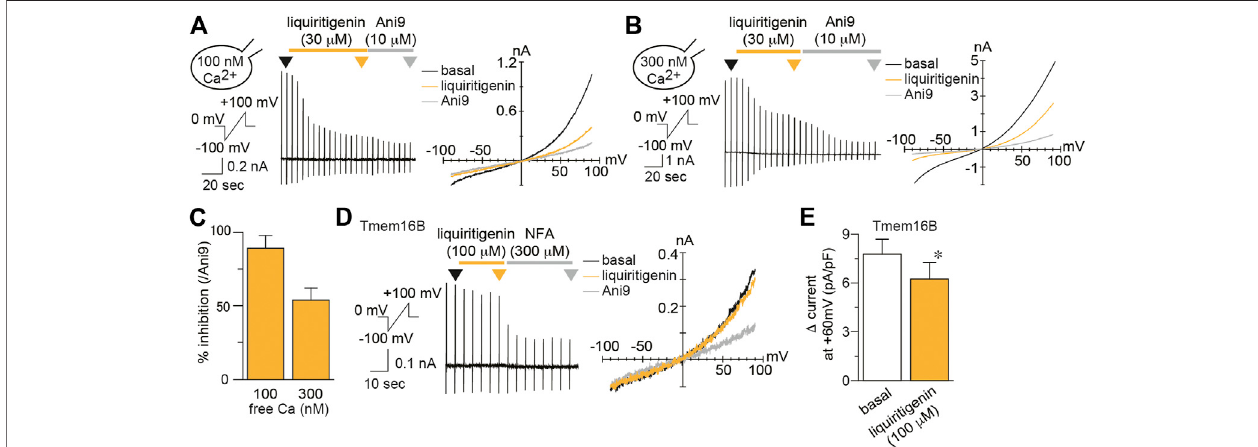
FIGURE 2 | Characterization of liquiritigenin (A – B) Typical traces (left) and current-voltage curves (right) of mTMEM16A currents induced by 100 nM (A) or 300 nM (B) intracellular free calcium during application of 30 µM liquiritigenin to HEK293T cells expressing mTMEM16A. The holding potential was 0 mV, and ramp pulses ( − 100 to +100 mV, 300 ms) were applied every 5 s. Typical current-voltage curves at the time indicated by black (basal), yellow (liquiritigenin), and gray (Ani9) arrowheads (C) Thepercentage ofinhibition causedby30 µMliquiritigeninappliedwith100and300 nMintracellular freecalciumconcentrations(n (cid:2) 5 – 6cells) (D) A typical trace (left) and current-voltage curves (right) of whole-cell chloride currents during application of 100 µM liquiritigenin in HEK293T cells expressing mTMEM16B. The holding potential was 0 mV, and ramp pulses ( − 100 to +100 mV, 300 ms) were applied every 5 s. Basal mTMEM16B currents were induced by 300 nM intracellularfreecalcium. Typical current-voltage curvesat the time indicated byblack (basal), yellow (liquiritigenin), and gray (ni fl umic acid, NFA) arrowheads (E) Comparisonofthe Δ currentsinHEK293TcellsexpressingmTMEM16Bat+60 mV(n (cid:2) 5 cells).Dataareshownasthemean ± SEM;* p < 0.05,Wilcoxonmatched-pairs signed rank